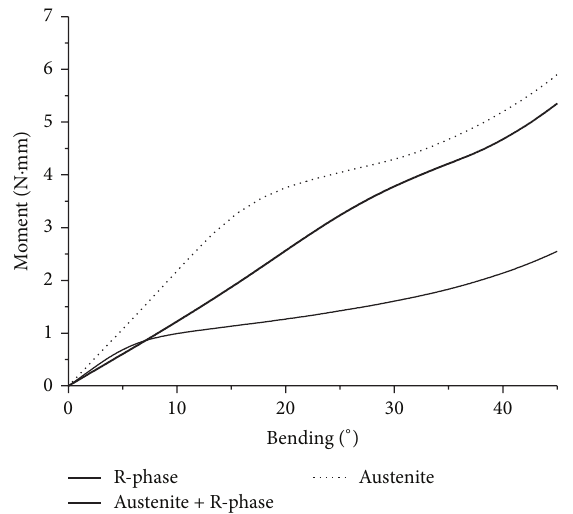
Figure 8: Simulated moment-bending curves for the same endodontic instrument with three different NiTi constitutive mod- els: austenite, austenite + R-phase, and R-phase.